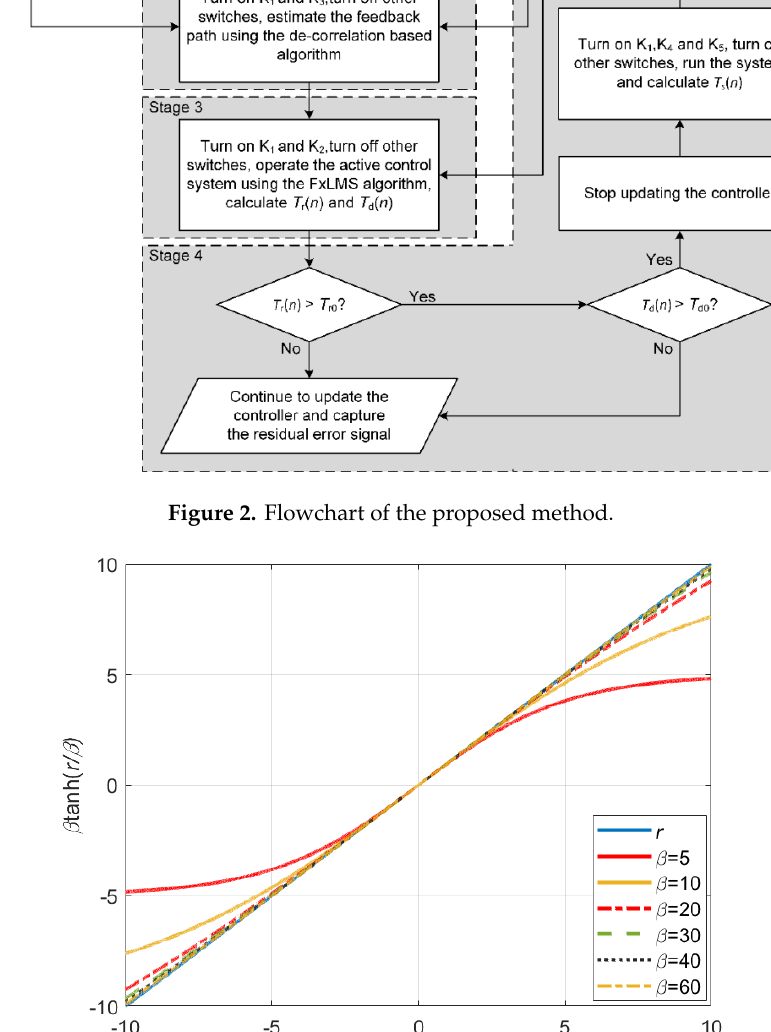
Figure 3. Effect of different value of β on mapping of r ( n ) to the linear range of tanh function.